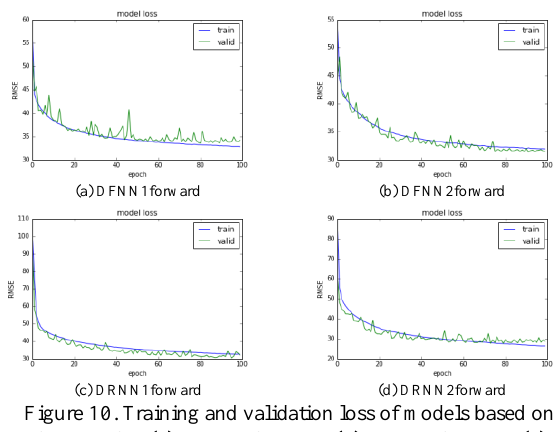
(d) DRNN2forward Figure 10. Training and validation loss of models based on forward-fix. (a) DFNN1forward, (b) DFNN2forward, (c) DRNN1forward,